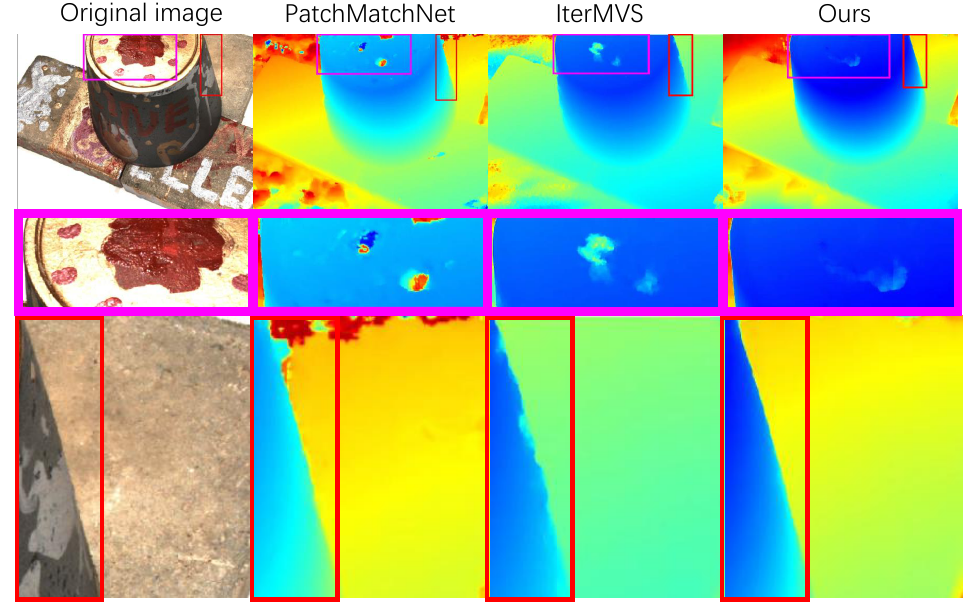
Figure 5. Depth estimation of scan1 on DTU. Our method has a clear advantage in reflections and edges, as shown in the red